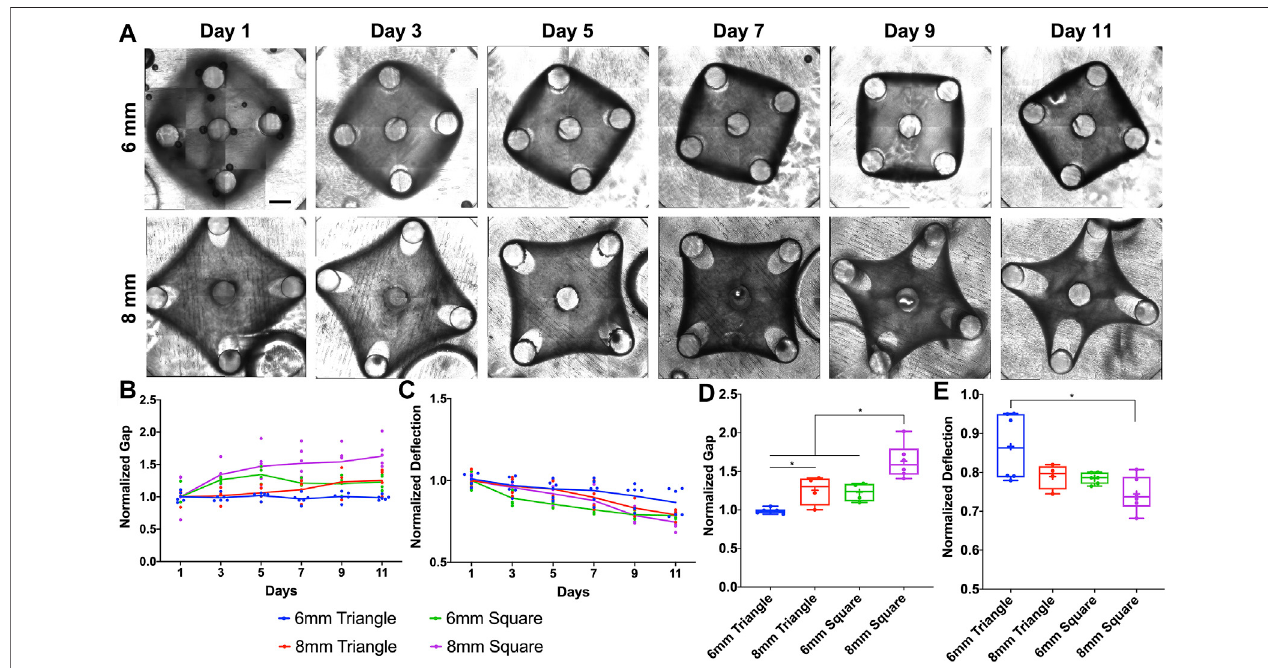
FIGURE 3 | Experimental results of morphological evolution of square mesenchymal tissues. (A) Representative images of tissue remodeling over 11 days for the squaretissuesofdifferentsidelengths. (B) Tissuethinningaroundthepostledtogapextension,and (C) inwardremodelingattheedgeledtode fl ectioncompaction.The gap and de fl ection were measured every 2 days for tissue comparison ( ▲ 6wC, ▲ 8wC, ∎ 6wC and ∎ 8wC). Taking the measurements on Day 11, (D) the gap was larger and (E) the de fl ection was smaller for the square tissues with longer side length. Scale bar: 1 mm * p < 0.05.